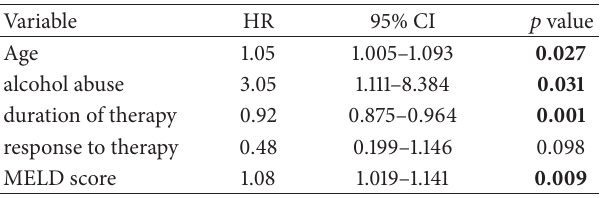
Table 3: Cox regression analysis and predictors of one-month mortality.